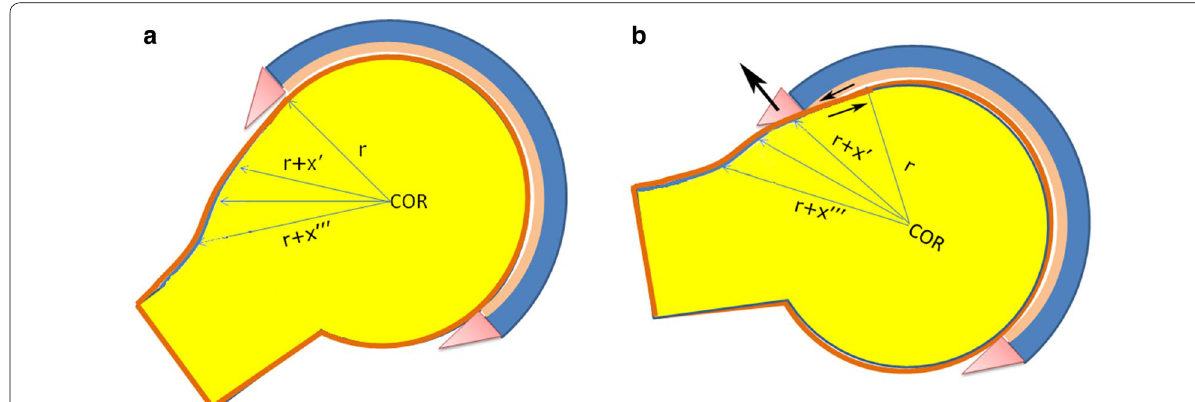
Fig. 1 Cam FAI. The cam intrusion is variable, depending on thickness and shape of cam, location, extent, lubrication, force, etc. ( COR center of rotation, r radius, x difference between head radius and cam extended radius). a Neutral joint position with cam dismorphism in the peripheral compartment; b cam